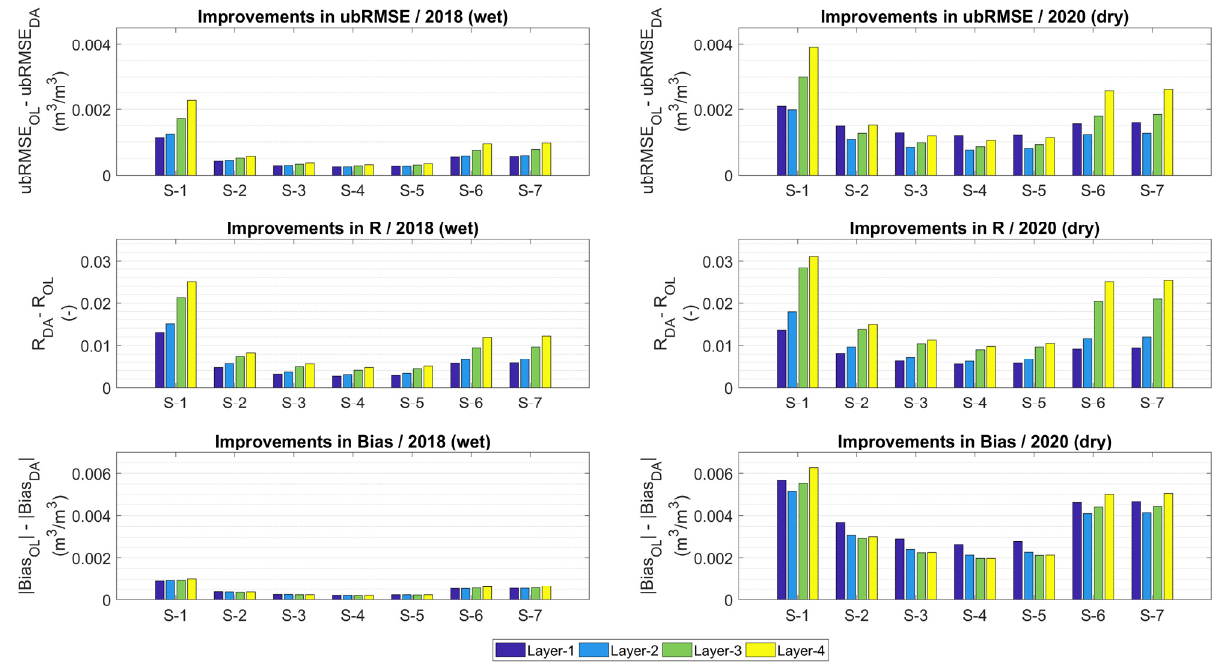
Figure 5. Basin-averaged soil moisture improvements in all scenarios for 2018 ( left ) and 2020 ( right ).